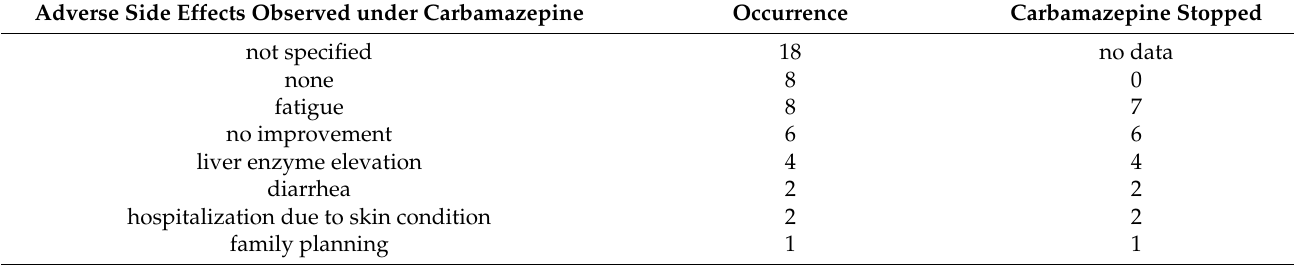
Table 2. Reported side effects